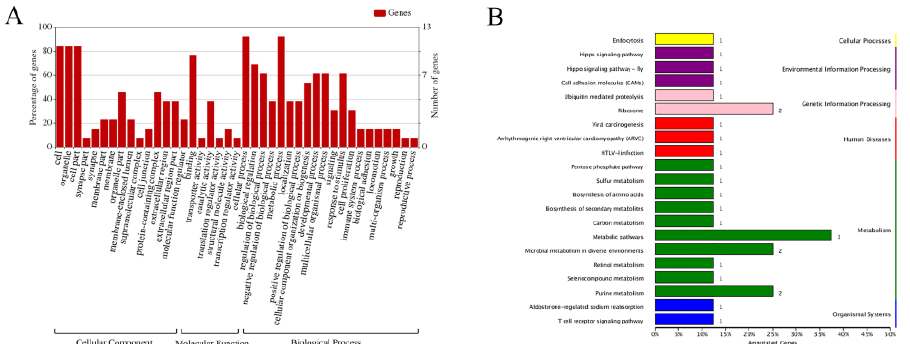
Figure 2. Functional classification and pathway analysis of the screened proteins. ( A ) The classifica- tion of the screened proteins was performed according to GO biological processes. All GO categories with a p value were chosen. The vertical axis is the percentage of genes, and the horizontal axis is the GO functional category. ( B ) Kyoto Encyclopedia of Genes and Genomes (KEGG) pathway enrichment analyses for the 19 host proteins interacting with ARV